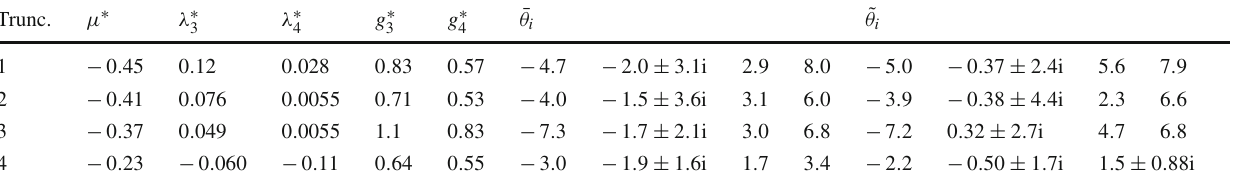
Table 3 Properties of the non-trivial UV fixed points for different approximations within the full system. In the truncations 3 and 4, we set η φ = 0, while in the truncations 1 and 2 we use momentum dependent i anomalous dimensions. In truncations 2 and 4, the couplings g 3 , 4 are computed via a derivative expansion at p = 0, while in the truncations 1 and 3 the couplings g 3 , 4 ( k 2 ) are evaluated with a bilocal projection between p = 0 and p = k . The quality of the truncation decreases from 1 to 4. The fixed point values are obtained with the identification